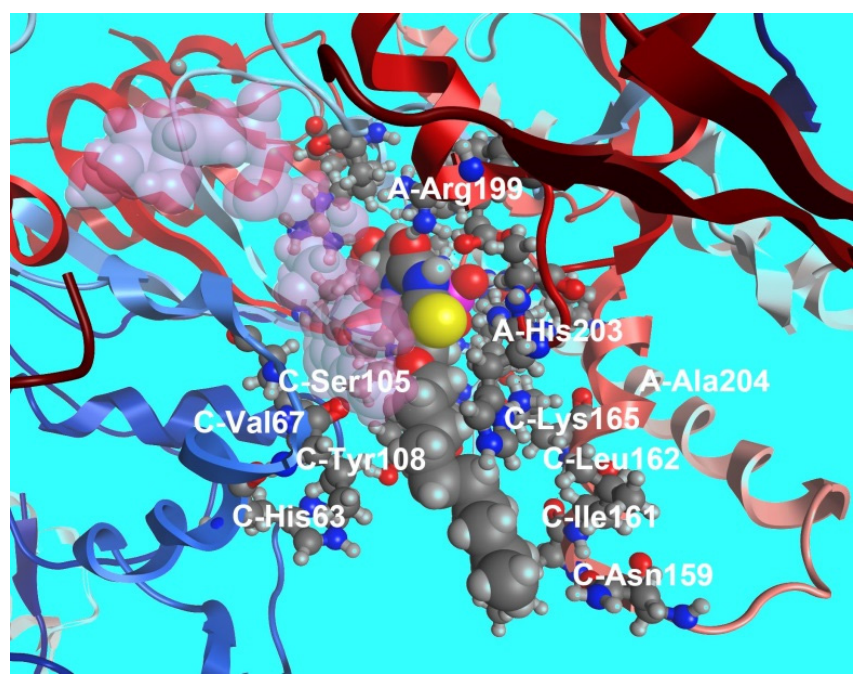
Figure 22. The proposed structure of the complex of 5-undecyloxymethyl-dUMP ( 79b ) with ThyX (based on docking).